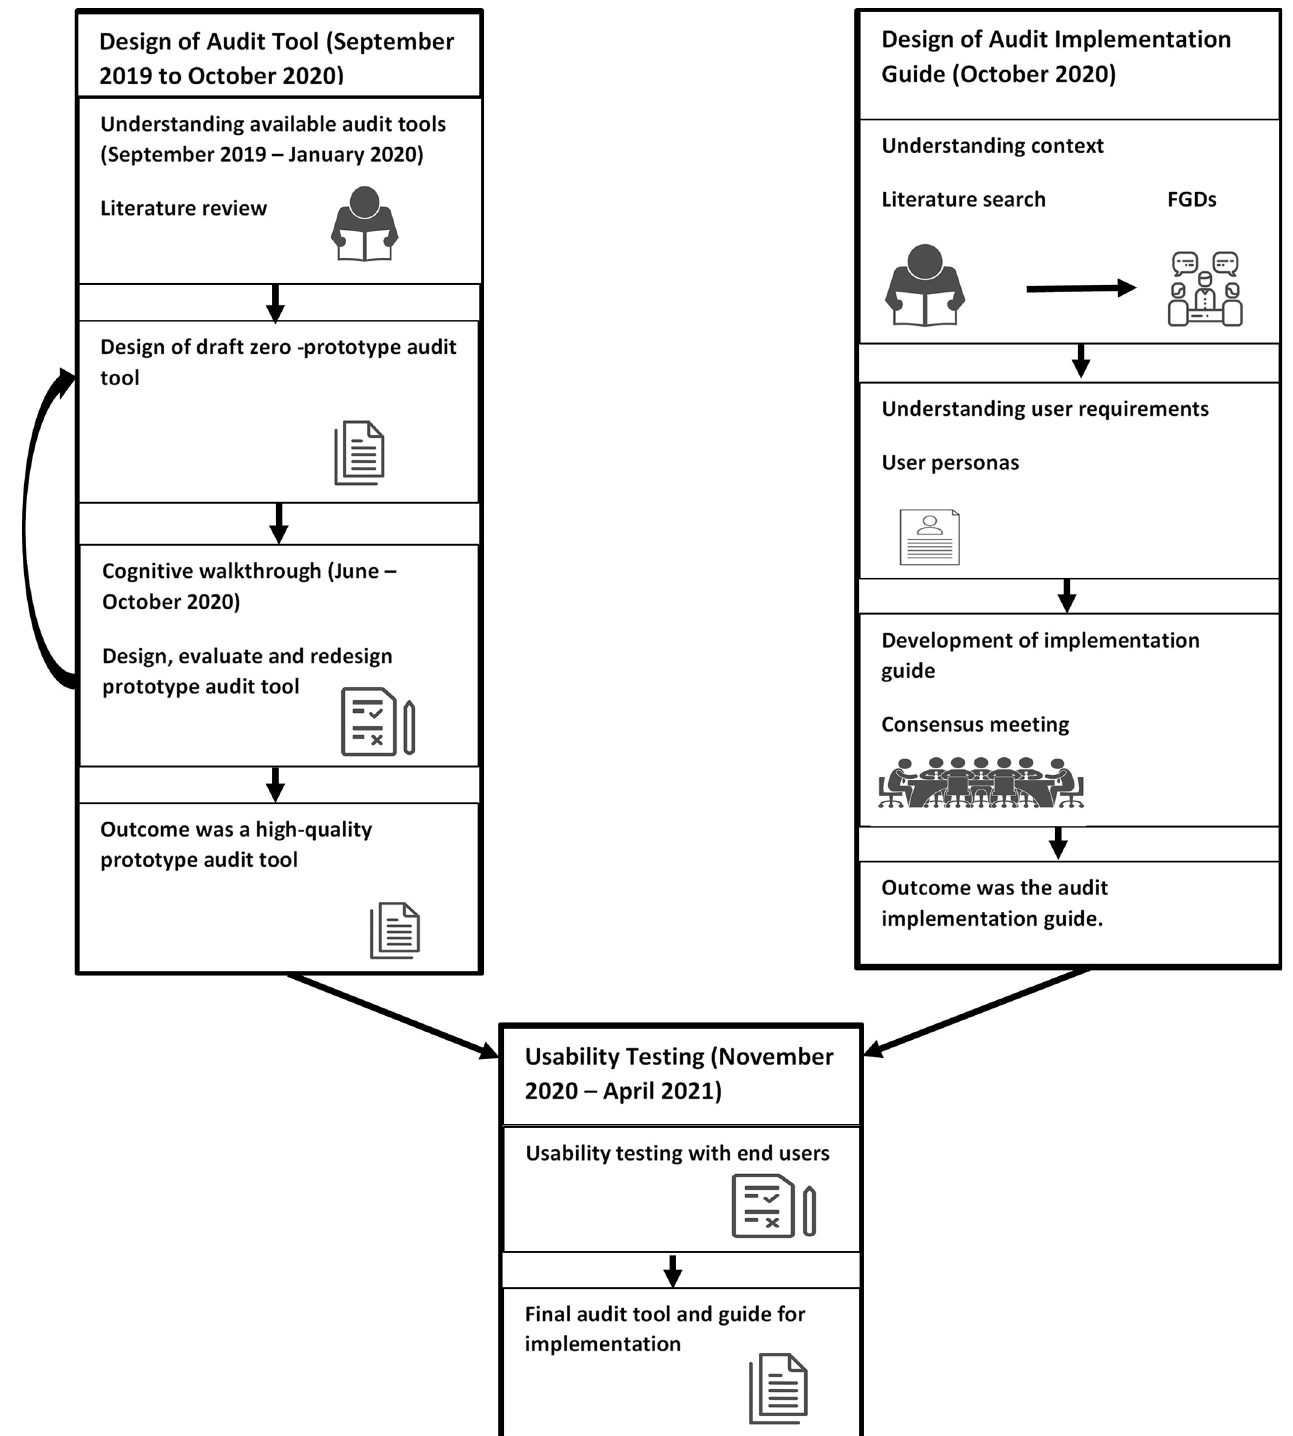
Fig 1. Human centred design approach of a small and sick newborn clinical audit tool and implementation guide.